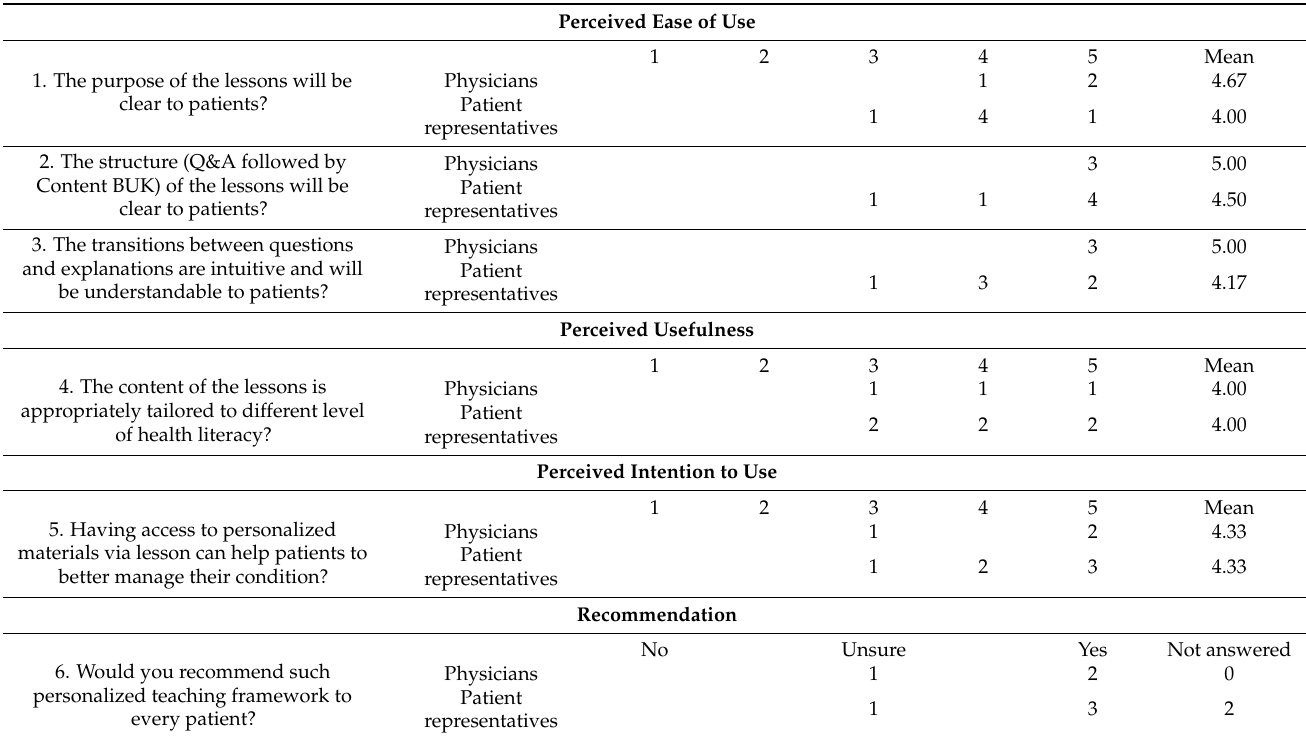
Table 4. Summary of the responses of collaborating end-users to the TAM-inspired questionnaire. Perceived Ease of